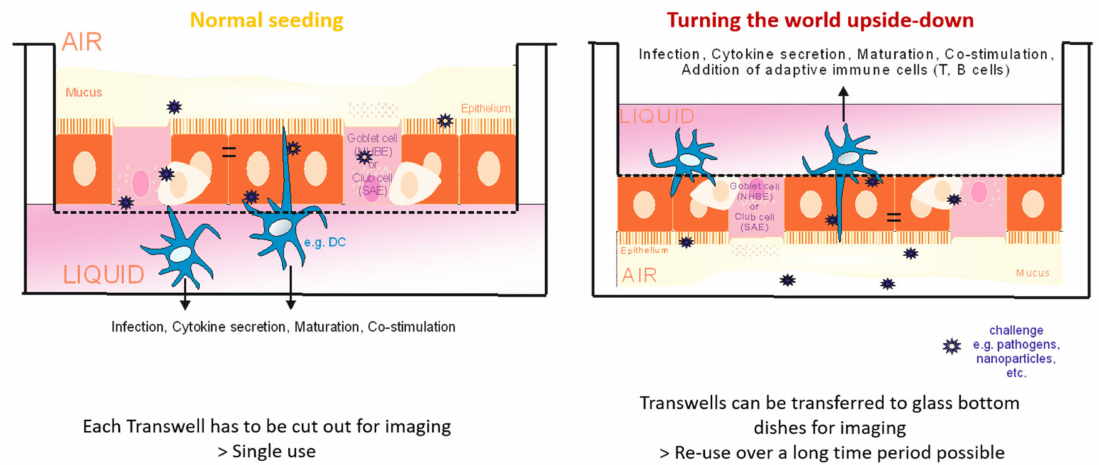
Figure 1. Normal seeding (left) of primary, respiratory epithelial cells (Normal Human Bronchial Epithelial (NHBE), small airway epithelia (SAE)) in cellulose-based GrowDex ® does not allow multiple uses of 3D grown tissue, since Transwell inserts have to be cut out or para ffi n-embedded for imaging analyses. Imaging is not possible from below due to the thickness of the filter-grown tissue and flipping of normally grown wells is not possible due to the side walls of the Transwell. Upside-down seeding of respiratory cells grown in GrowDex ® allows an easy transfer of the Transwell to a glass-bottom dish by lifting the Transwell insert to the other dish under sterile conditions. After-life cell imaging analyses are done, the Transwell insert is transferred back into the original well. Therefore, among many other applications, cell di ff erentiation and mucociliary clearance can be monitored using the same cells grown in an animal-free cellulose